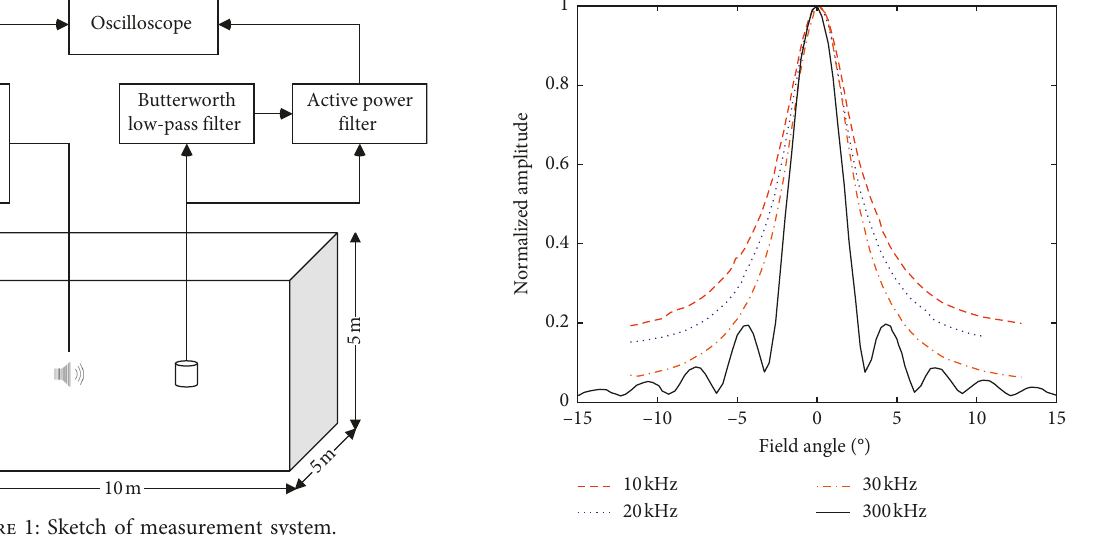
Figure 2: Directivity of the original frequency and difference frequency signals.